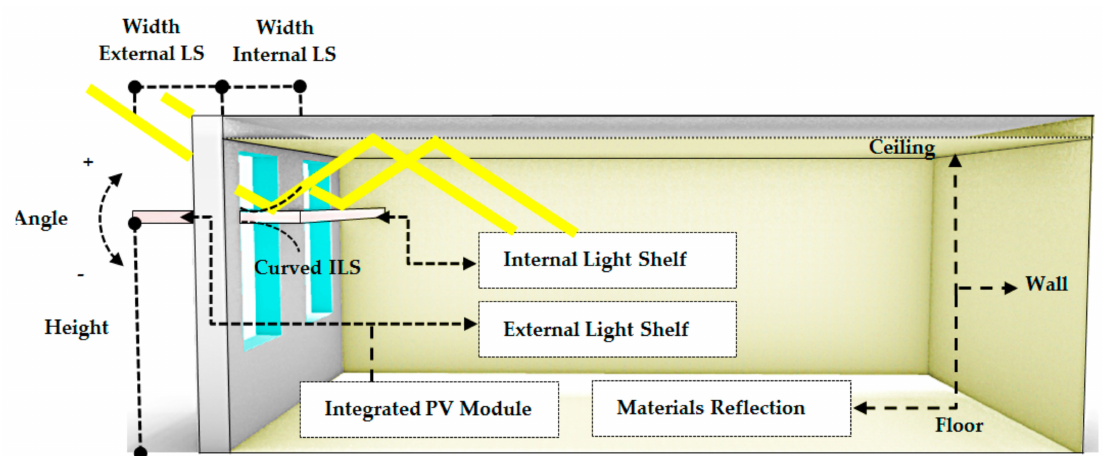
Figure1. Designsolutionsandvariablesassociatedwithalightshelfthatinfluencethedaylightdistribution.